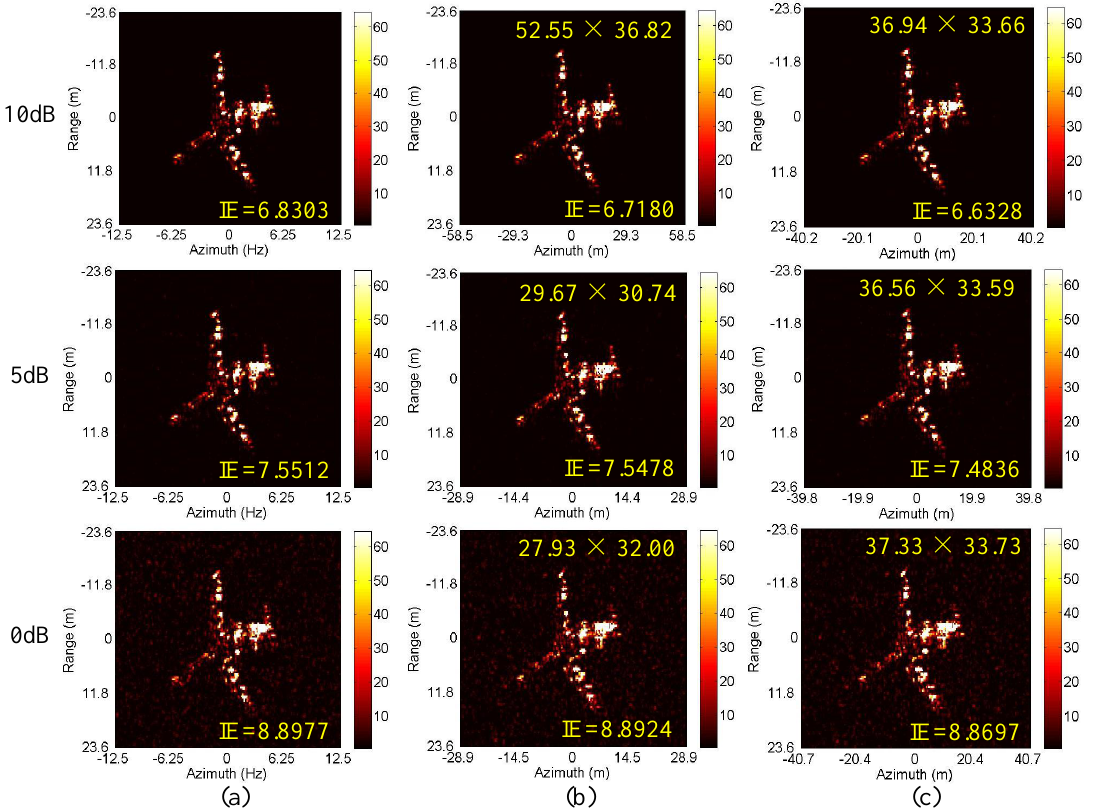
Figure 10. The imaging results of di ff erent algorithms at di ff erent SNRs. ( a ) IMCM-PGA. ( b ) IMCM-PGA-TAS. ( c )